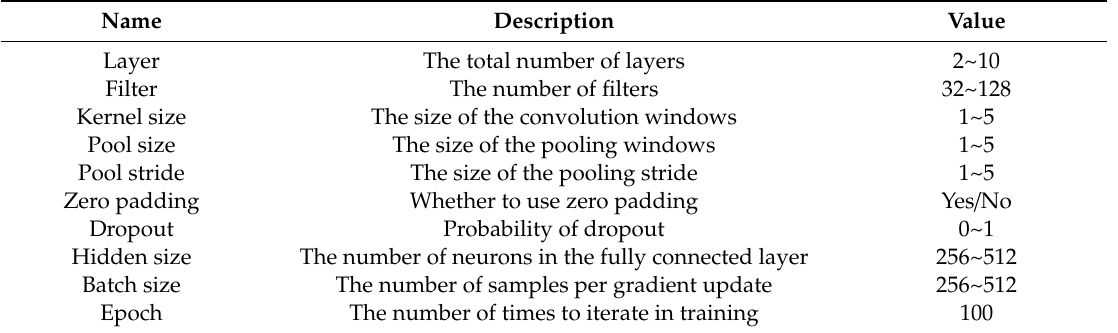
Table 5. The list of